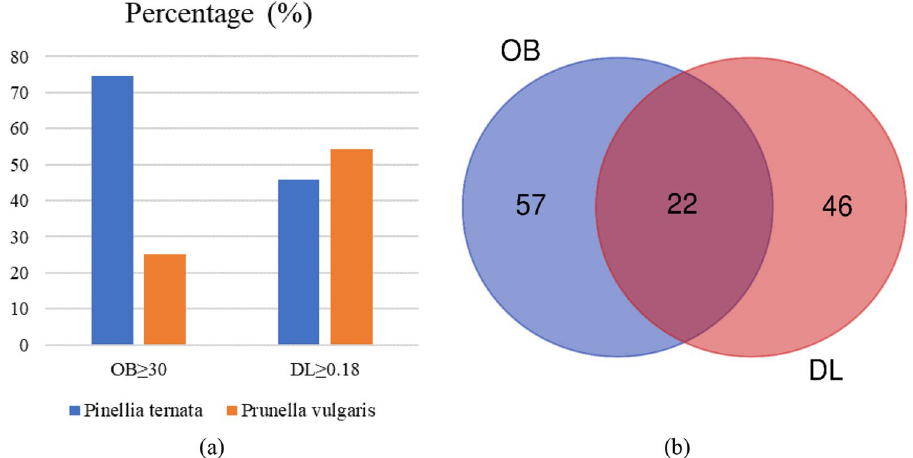
Figure 3. Active compounds in Banxia-Xiakucao Chinese Herb Pair. ( a ) and ( b ) Absorption, distribution, metabolism, and excretion (ADME) data for Pinellia ternate (Banxia) and Prunella vulgaris (Xiakucao). OB, oral bioavailability; DL,